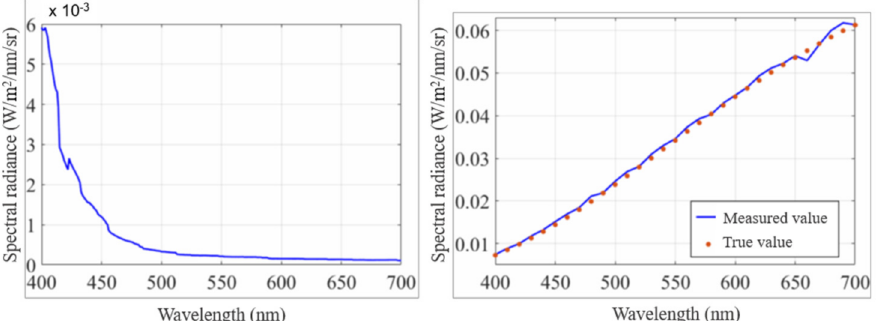
Figure 7. Calibration test of USI system in the air. Unit pixel response corresponding to absolute spectral radiance ( left ). Calibration relationship test results ( right